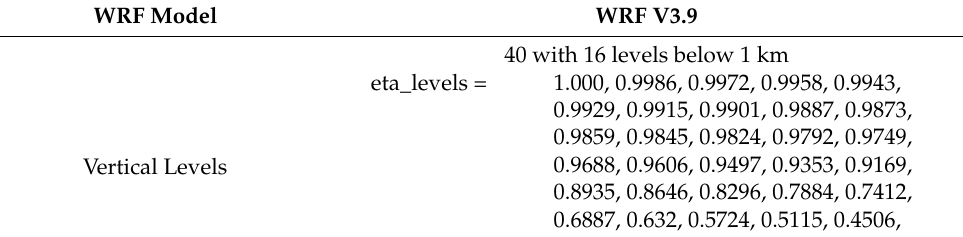
Table 2. Cont. WRF